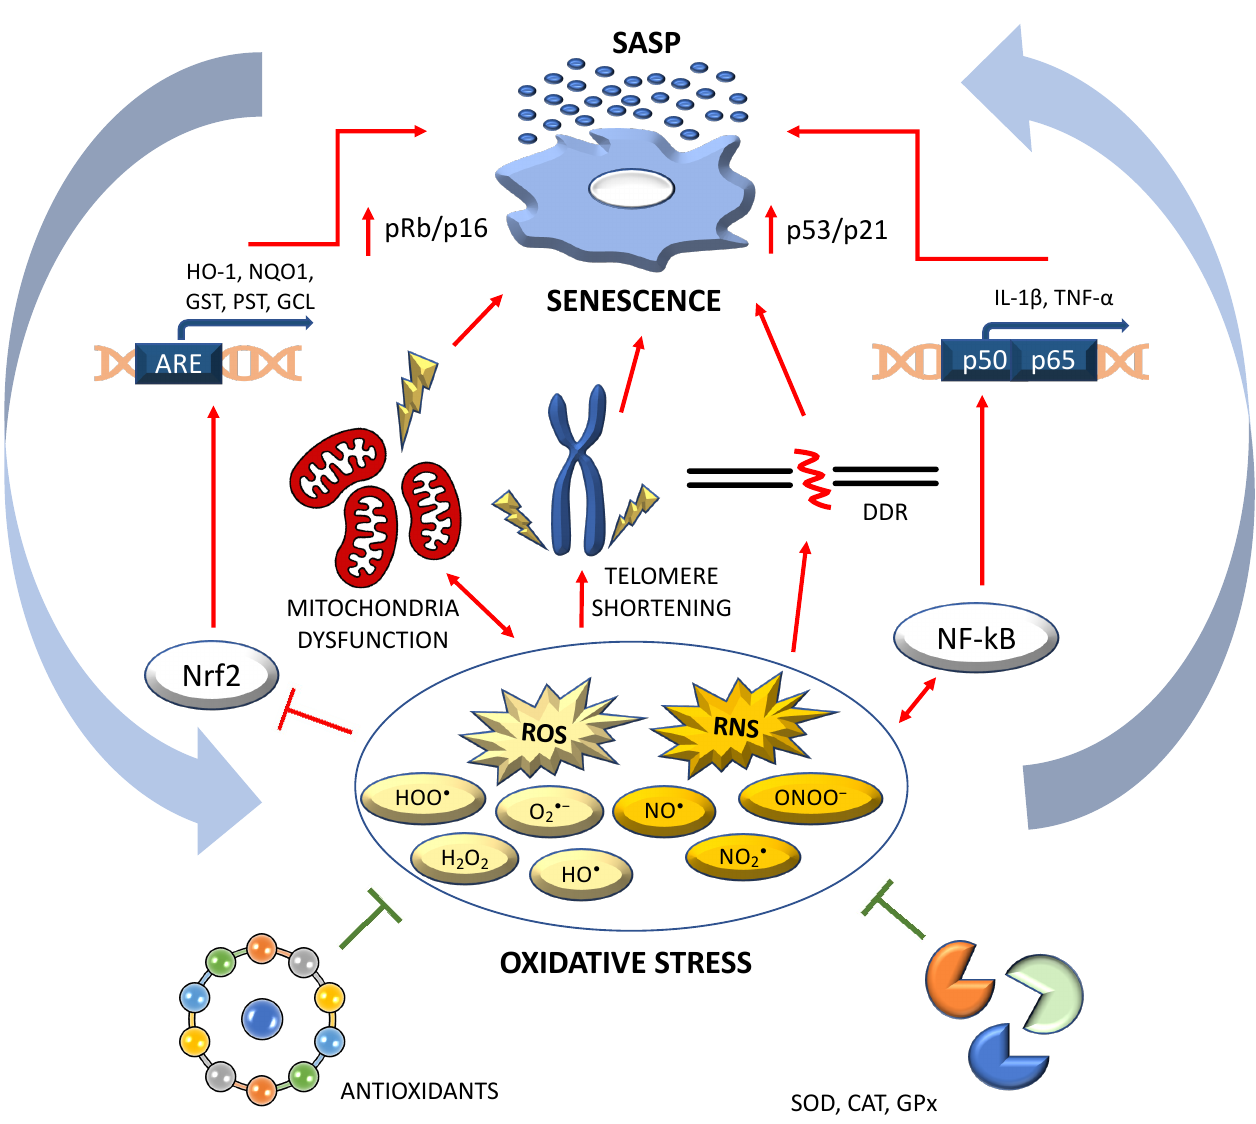
Figure 1. The interplay between oxidative stress (OS) and senescence. Excessive reactive oxygen species (ROS) and reactive nitrogen species (RNS) trigger senescence through different mecha- nisms: (i) via NF-kB stimulation, which induces the transcription of the main factors composing the senescence-associated secretory phenotype (SASP); (ii) through DNA double strand brakes, which trigger a sustained DDR response; (iii) via telomere shortening, which is directly linked to cellular senescence; (iv) through a double cross-talk between mitochondria dysfunction and ROS/RNS pro- duction and (v) via the inhibition of Nrf2, a crucial antioxidant transcription factor. Antioxidant molecules and antioxidant enzymes (i.e., superoxide dismutase, catalase and glutathione perox- idase) can counteract senescence through the inhibition of OS. Abbreviations: ARE: antioxidant responsive element; CAT: catalase; DDR: DNA damage response; GCL: glutamate cysteine ligase; GPx: glutathione peroxidase; GST: glutathione transferase; H 2 O 2 : hydrogen peroxide; HO-1: